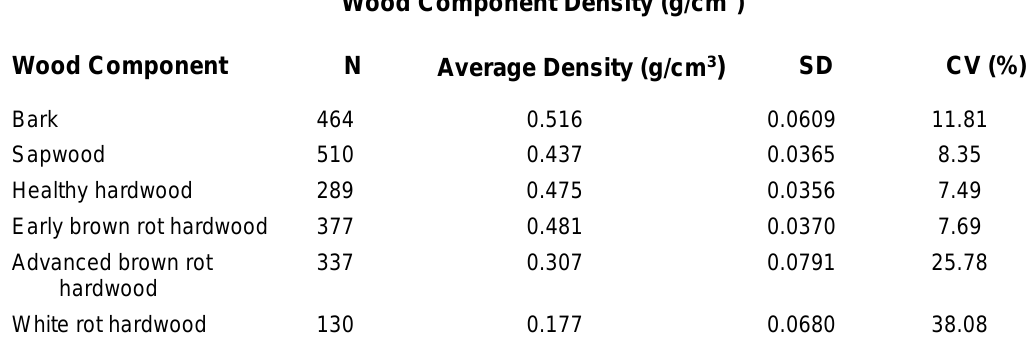
Wood Component Density (g/cm 3